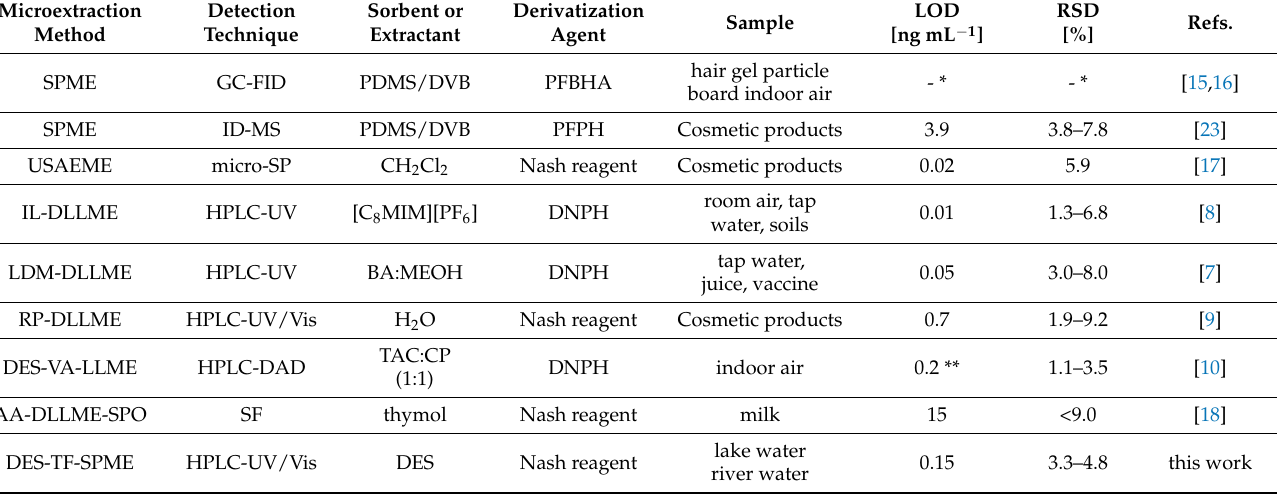
Table 5. Overview of the analytical performance of different microextraction methods for preconcen- tration of formaldehyde and comparison with the proposed